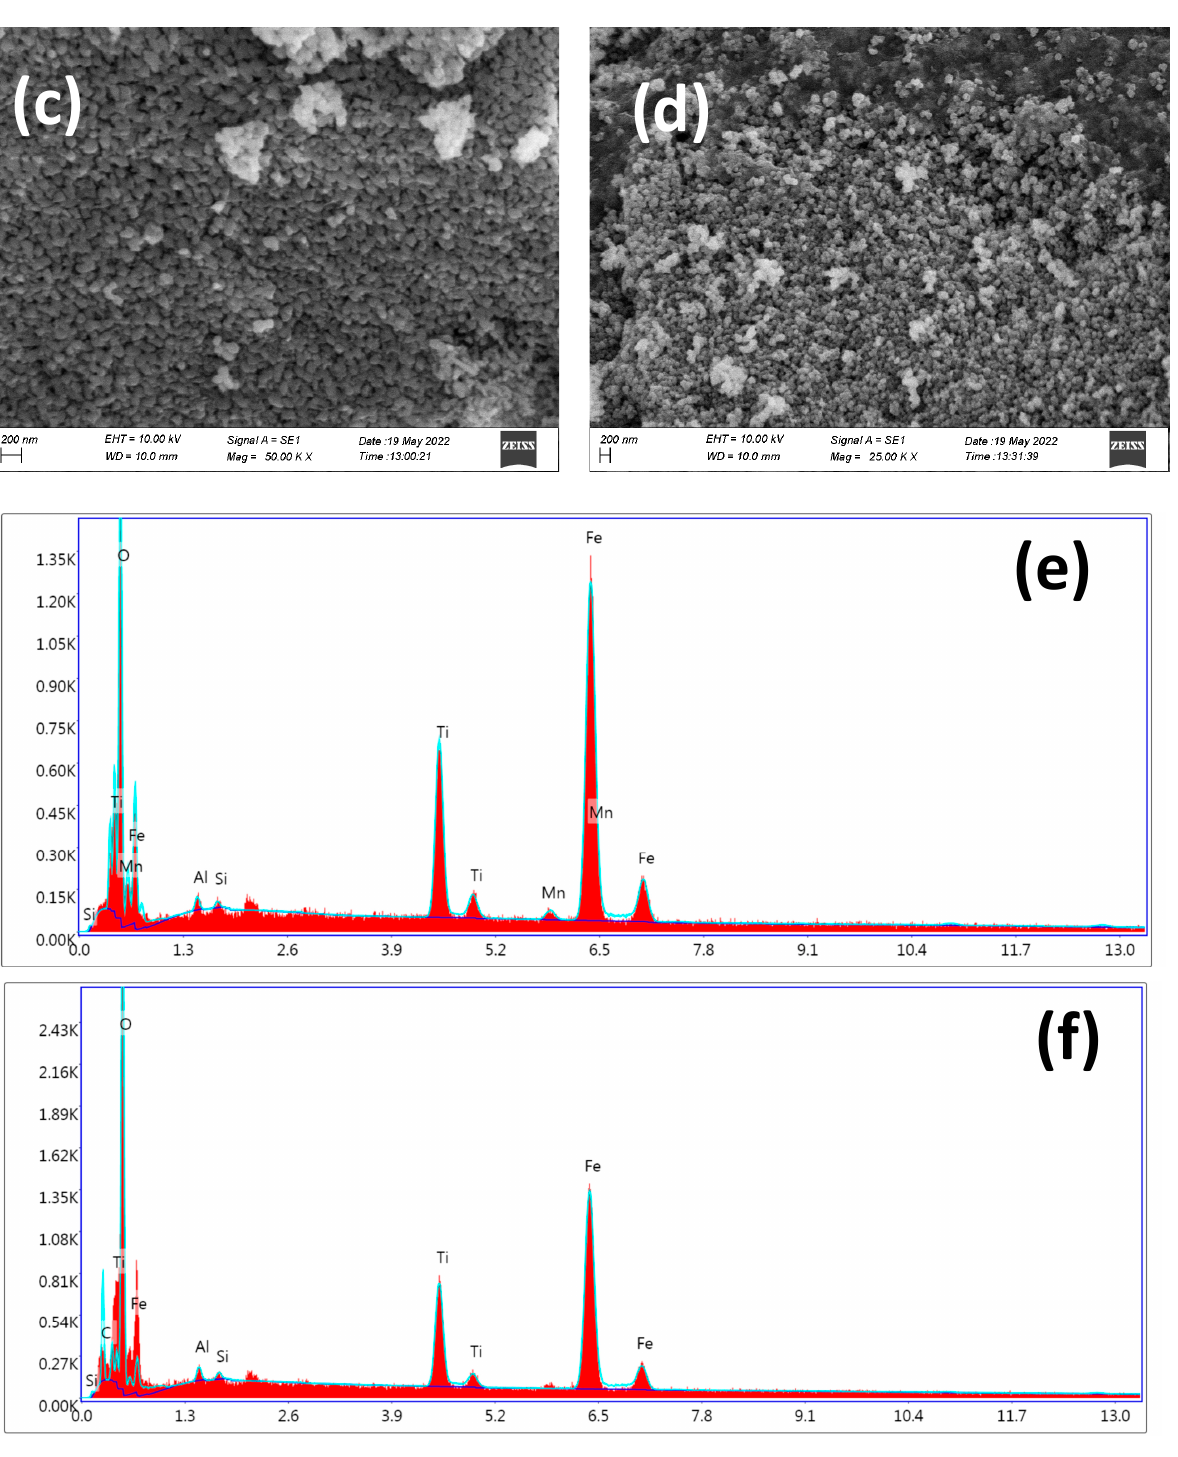
Figure 1. SEM images of ( a ) ilmenite sand ( b ) GO ( d , e ), ( c ) TF composite ( d ) (0.3)r-GOTF composite, EDX spectra of ( e ) TF composite and ( f ) (0.3)r-GOTF composite.